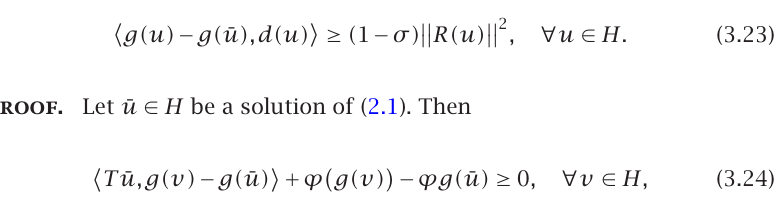
Algorithm 3.6 appears to be a new one even for general variational